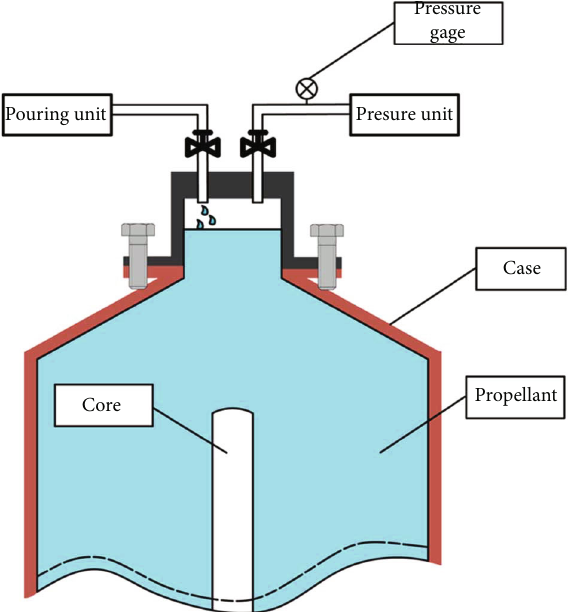
Figure 1: Equipment of pressure cure.